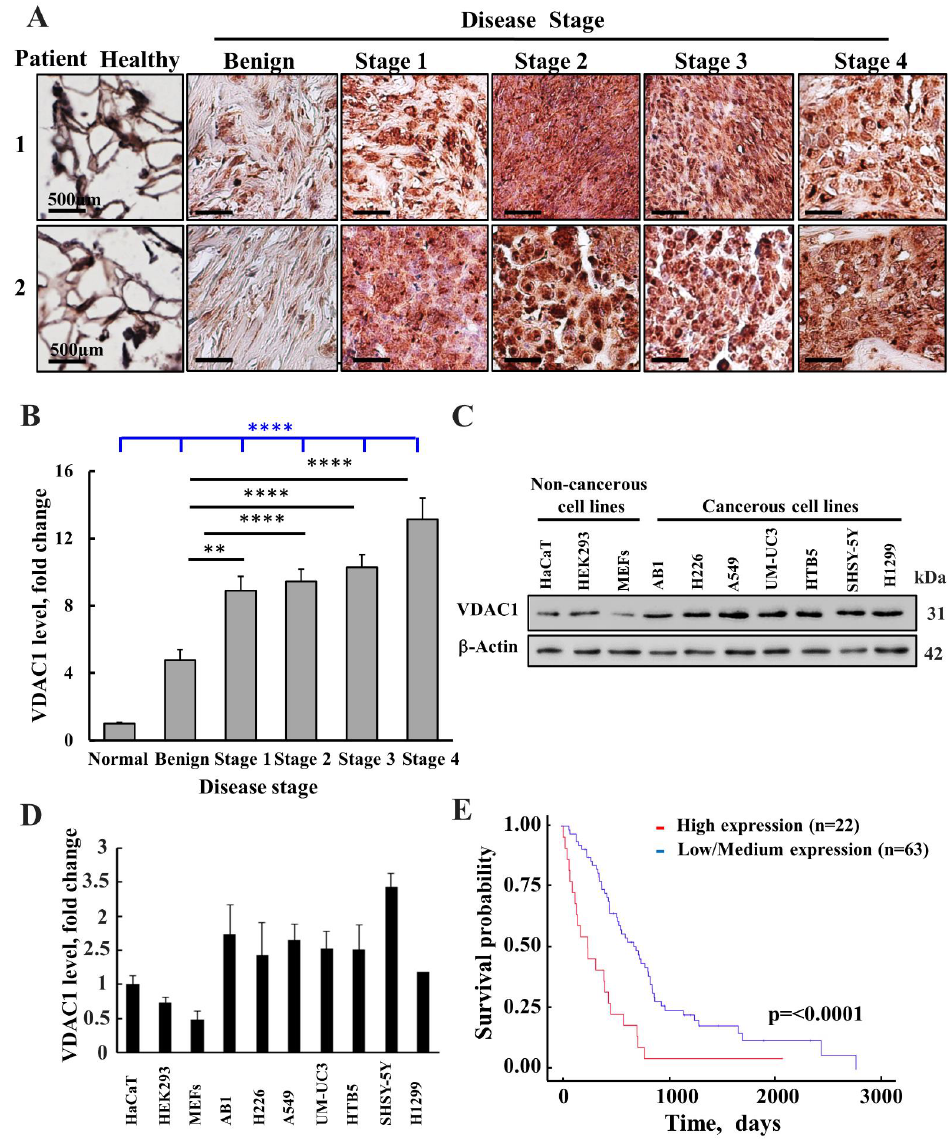
Figure 1. VDAC1 is over-expressed in mesothelioma patients and cancer cell lines. ( A ) Representative IHC staining for VDAC1 in healthy (n = 8) and mesothelioma at different disease stages (n = 52). Samples from tissue microarray slide (US Biomax MS801b; normal, benign and malignant; US Biomax MS1001a; malignant) samples from two patients at each disease stage are presented. ( B ) Quantitative analysis of VDAC1 levels in the tissue array samples at different disease stages. The results are means ± SEM (n = 18, 14, 14, and 6 for Stages 1, 2, 3, and 4, respectively), ** p ≤ 0.01; **** p ≤ 0.0001. Black lines are relative to benign tumors. The blue line is relative to healthy donors. ( C ) VDAC1 expression levels in different cell lines as analyzed by immunoblotting. ( D ) Quantitative analysis of VDAC1 levels in the indicated cell lines. ( E ) A Kaplan–Meier plot depicting patient survival rate with correlation to low/medium (blue line) or high (red line) VDAC1 expression levels. The initial numbers of patients for VDAC1 expression levels that were low/medium was 63 and for high 22, p = 0.0001. Data were obtained from: http://ualcan.path.uab.edu/ (accessed on 15 May 2022)